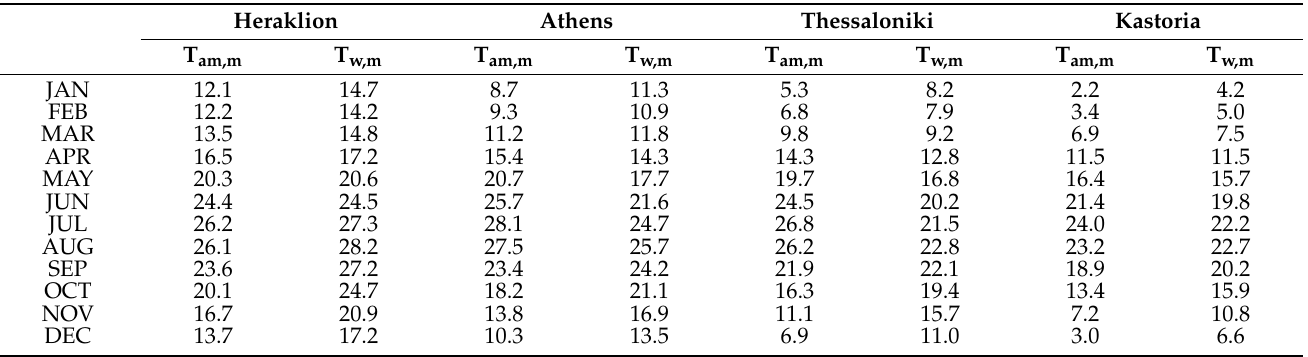
Table 6. Mean monthly air temperature (T am,m ) and mean water temperature from the grid (T w,m ) expressed in [ ◦